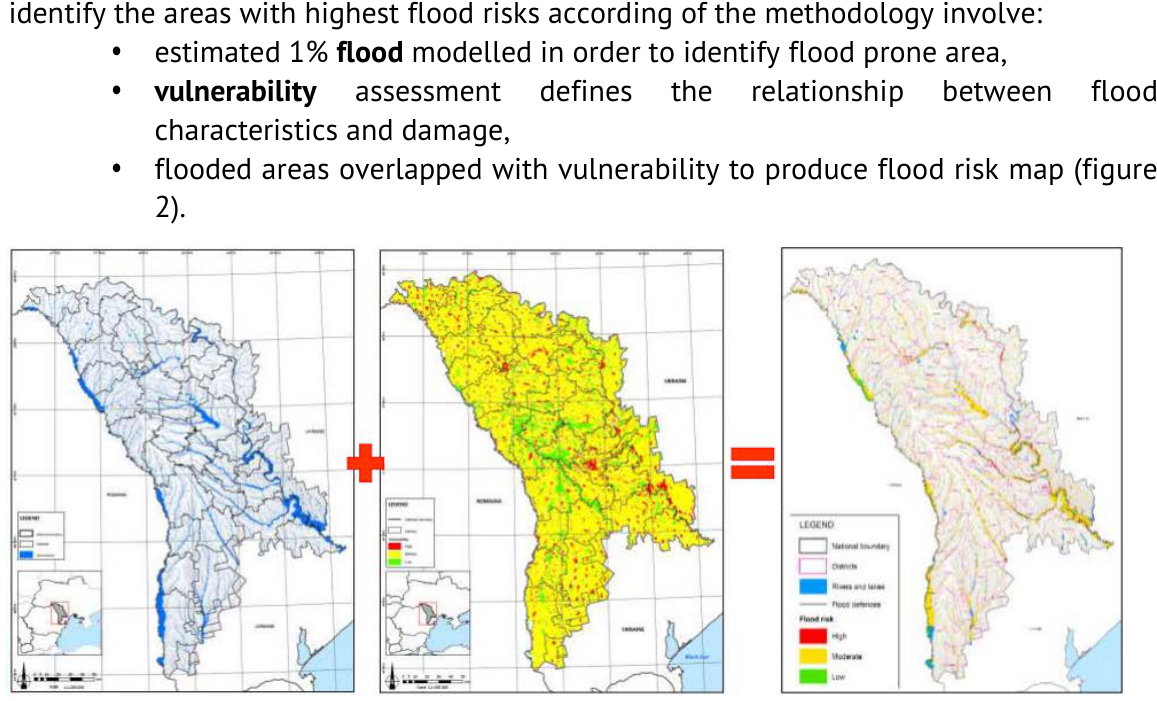
Figure 2. Graphical interpretation of the process for creation of the risk maps.